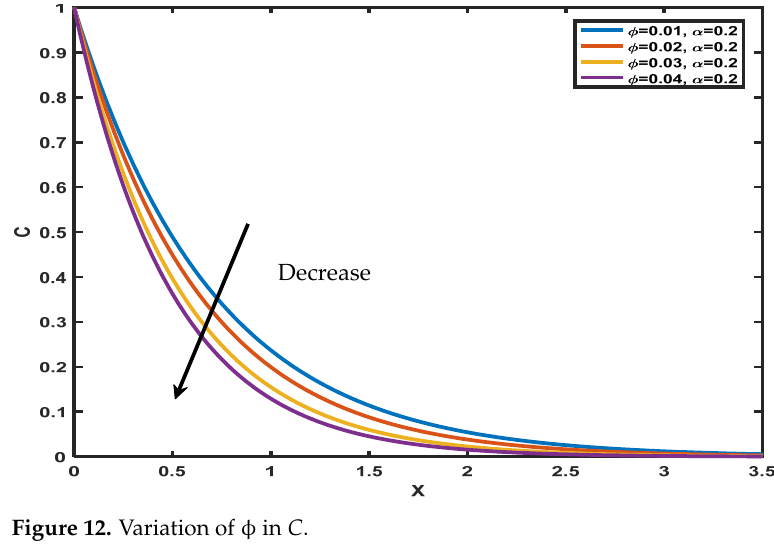
Figure 12. Variation of φ in C .